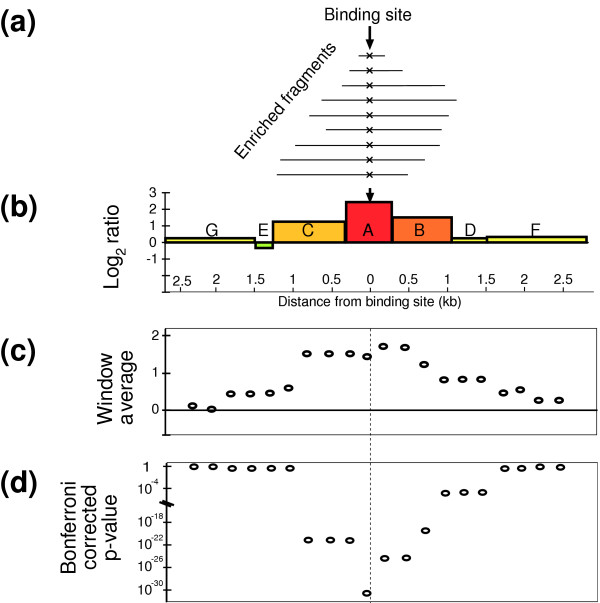
The neighbor effect and calculation of P values. (a) After ChIP, purified DNA fragments bound by the protein of interest will be of various lengths. (b) Actual log2 ratios reported by arrayed elements for Rap1p binding to promoter region of RPL1B (array element 'A') from the Rap1p binding dataset reported by Lieb and coworkers [13]. Arrayed element 'A' contains the actual site of protein-DNA interaction, and so this spot will have the highest ratio (red = high positive ratio; yellow = low ratio; green = negative ratio). Arrayed elements 'B' (RPL1B open reading frame [ORF]) and 'C' (MRM2 ORF), which are within about 1 kilobase (kb) of the binding site, are also enriched above noise. Arrayed element 'B' has a higher ratio then spot 'C', because the binding site is located closer to element 'B'. The arrayed elements 'D', 'E', 'F', and 'G' are too far from the binding site to be enriched. (c) Using a 1 kb window with a 0.25 kb step, the value of each window is plotted. The location of each window is defined by its central coordinate. (d) The P value of each window is plotted. The Bonferroni corrected P values were calculated based on the observed data, which had a log2 background standard deviation of 0.32 with 21,208 comparisons. Note that the window with the smallest P value (about 10-30) does not correspond to the highest window average. This is due to the fact that the most significant window contains three arrayed elements (A, B, and C), whereas the windows with the highest average contain only two elements (A and B). In this case, the center of the window with the highest P value is located about 80 bases from the actual binding site.